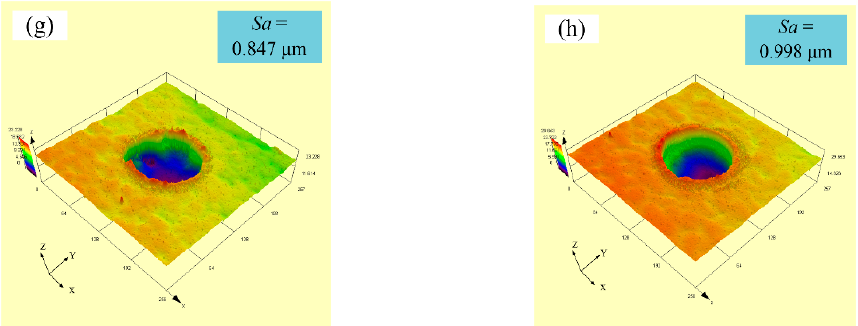
Figure 5. Experimental three-dimensional images with varying laser output power: ( a ) 50 W; ( b ) 60 W; ( c ) 70 W; ( d ) 80 W; ( e ) 90 W; ( f ) 100 W; ( g ) 110 W; ( h ) 120 W. To further have better comparison and analysis, the experimental two-dimensional (2D) cross-sectional profiles obtained from Figure 5 were shown in Figure 6. It can be seen from Figure 6 that the average bump height of the convex dome on the samples’ surface with a laser output power of 50 and 60 W was 1.39 and 1.74 µm, respectively. However, it was noted that there was a small dimple with a depth of 4.81 µm when the laser output power was 70 W. Additionally, further increase in the laser output power caused the dimple depth to increase, reaching a maximum value of 23.87 µm at 120 W, which penetrated through the coatings and reached the steel C1045 substrate’s surface.